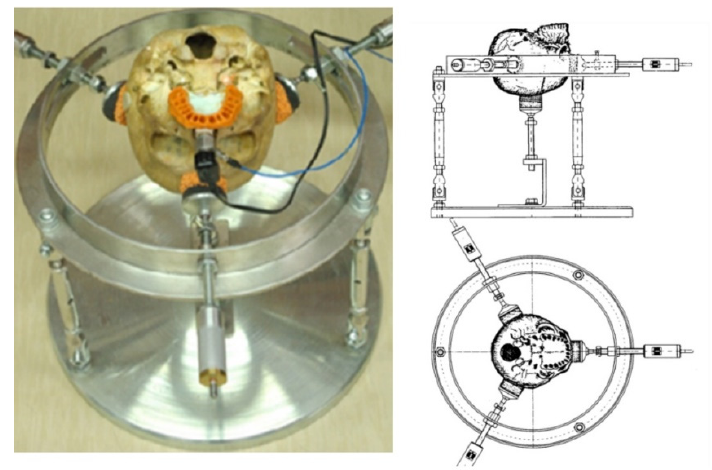
Figure 2. The skull fixed on a stand.